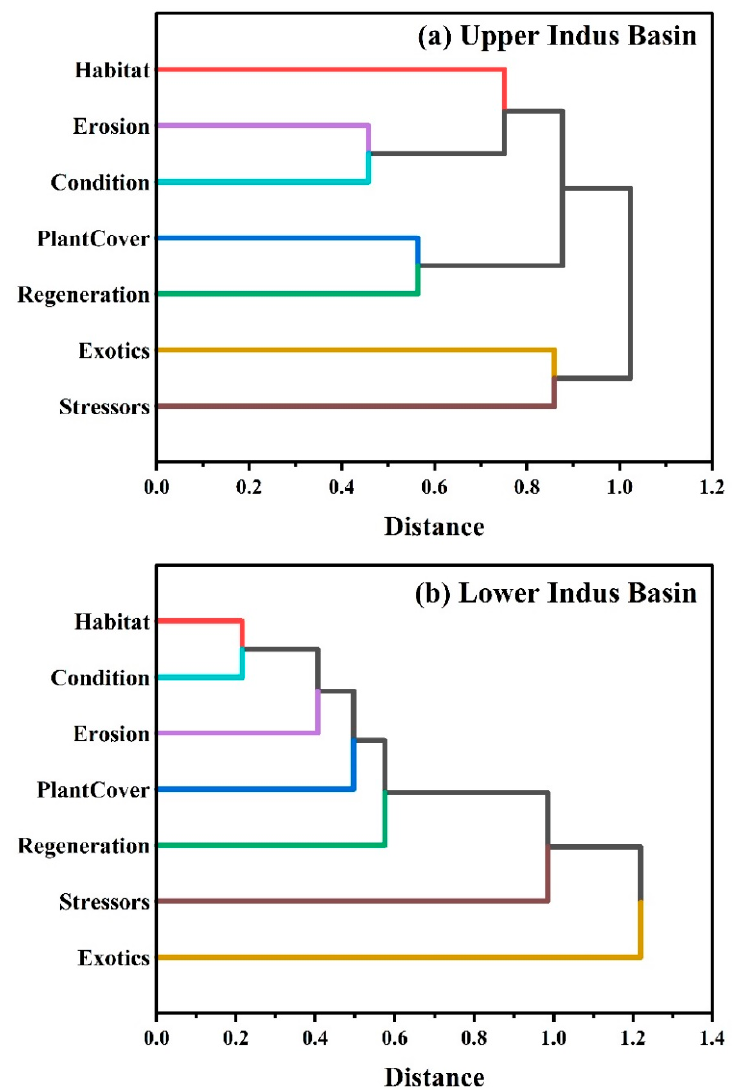
Figure 6. Dendrograms produced by agglomerative hierarchical clustering for riparian health indi- cators sub-indexes/index with stressors index for the upper ( a ) and lower ( b ) Indus basin riparian zones of the Indus River in Pakistan.